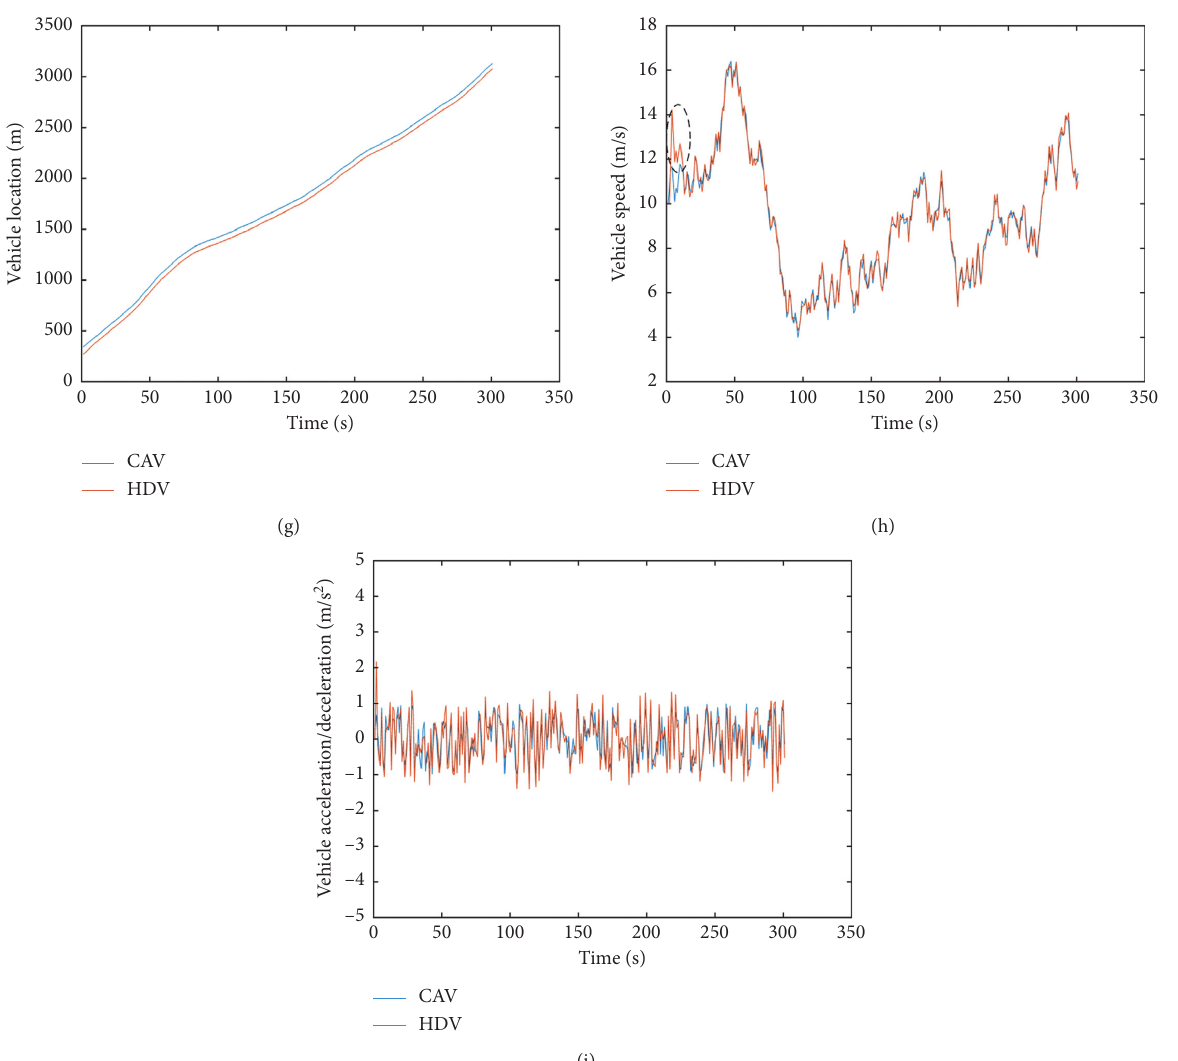
Figure 4: The car-following behavior of HDVs in the fleet within dense fog environment on highway. (a) The vehicle location of CAVs and HDVs ( L � 40m). (b) The vehicle speed of CAVs and HDVs ( L � 40m). (c) The vehicle acceleration of CAVs and HDVs ( L � 40 m). (d) The vehicle location of CAVs and HDVs ( L � 60m). (e) The vehicle speed of CAVs and HDVs ( L � 60 m). (f) The vehicle acceleration of CAVs and HDVs ( L � 60m). (g) The vehicle location of CAVs and HDVs ( L � 70 m). (h) The vehicle speed of CAVs and HDVs ( L � 70m). (i) The vehicle acceleration of CAVs and HDVs ( L �